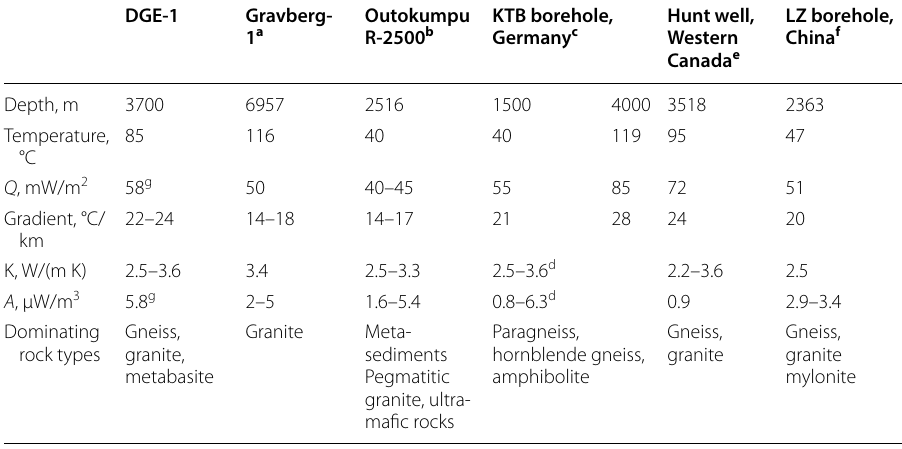
Table 3 Comparison of thermal data from the DGE-1 well with other deep boreholes drilled in the crystalline upper